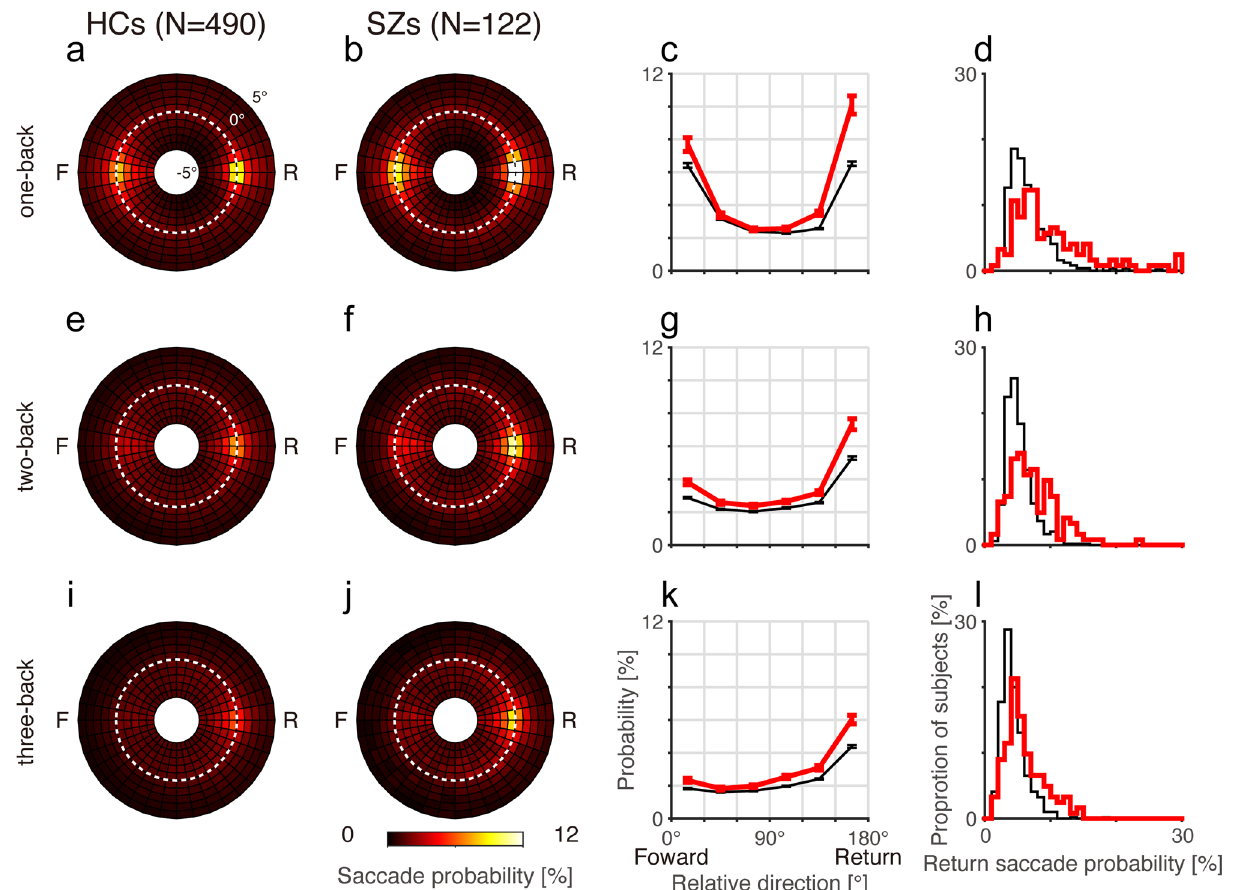
Figure 3. Mean saccade probability maps for the one-back (top), two-back (middle), and three-back (bottom) fixation locations for HCs ( a , e , i ) and SZs ( b , f , j ). Conventions are the same as in Fig. 2a,b. ( c , g , k ) Mean saccade probabilities plotted against relative saccade directions for amplitude-matched saccades for HCs (thin black lines) and SZs (thick red lines). Error bars indicate standard errors. ( d , h , l ) Frequency histograms of the return saccade probability for HCs (thin black lines) and SZs (thick red lines).